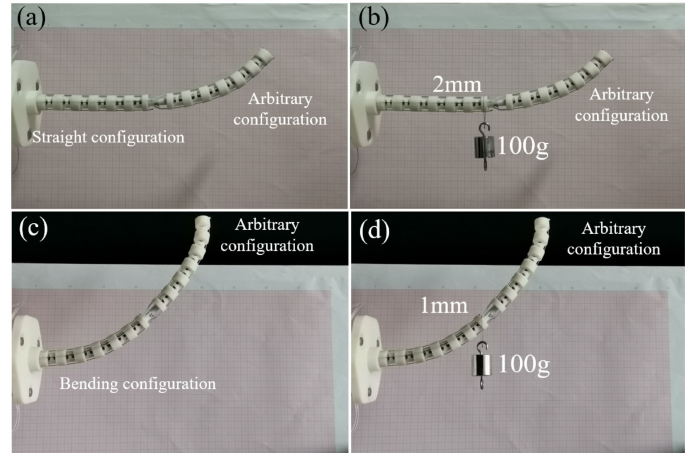
Figure 24. The 1 N load experiment on the end of the proximal segment. ( a ) The initial configuration of the proximal segment and the bending configuration of the distal segment. ( b ) 1N load experiment on the end in the straight configuration. ( c ) The bending configuration of the proximal segment and the bending configuration of the distal segment. ( d ) 1N load experiment on the end in the bending configuration.